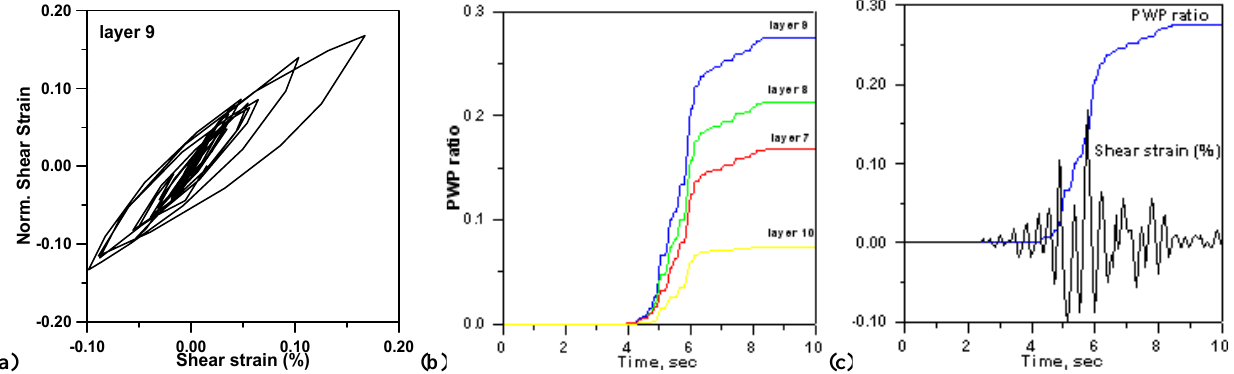
Figure 14 Fig. 14. Stress-strain history (a) for the layer with high probability to liquefy; PWP time histories at different ground level (b) ; PWP and Figure 14 shear strain time histories c) for the layer with high probability to liquefy.